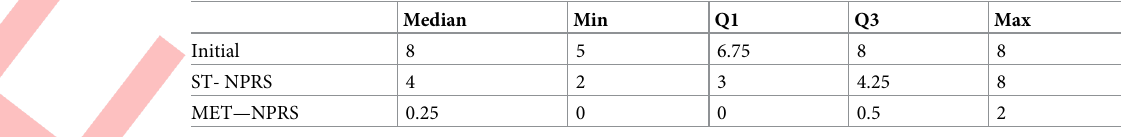
sion with relation to age and group (FOS HGT simulated patients (N = 1350), NHANES non- diabetic simulated patients (n = 1592) versus FM patients (n = 23). Differences among the (initial, ST-NPRS, MET-NPRS) were pairwise estimated using the sign test, followed by Hom- performed using R statistical software (R Core Team, 2018, version 3.5.1). All statistical tests assumed a 95% level of confidence, with alpha = 0.05. Table 2. Median Min Q1 Q3 Max Initial 8 5 6.75 8 8 ST- NPRS 4 2 3 4.25 8 MET—NPRS 0.25 0 0 0.5 2 Numerical Pain Rating Scores. All pairwise differences among the groups were significant, p < 0.0001, per the sign test and following adjustment for multiple